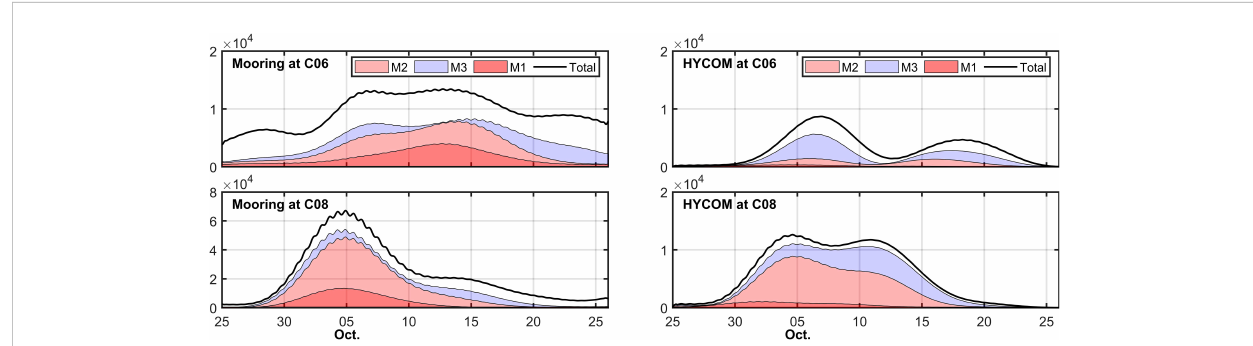
FIGURE 3 Time evolution of depth-integrated kinetic energy of different modes (unit: J/m 2 ), where M1, M2, M3 and Total denote the fi rst, second and third mode and total NIKE